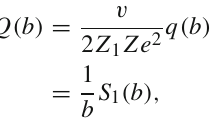
ence between functions d σ/ d σ R ( q ) at different values of the parameter Z 1 Ze 2 / ¯ h v